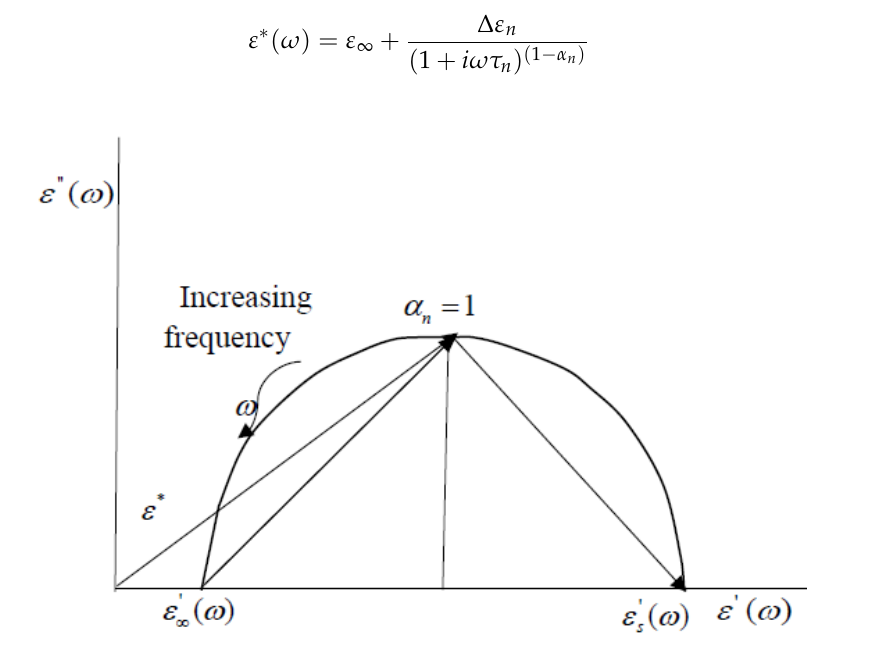
Figure 2. Cole–Cole parametric